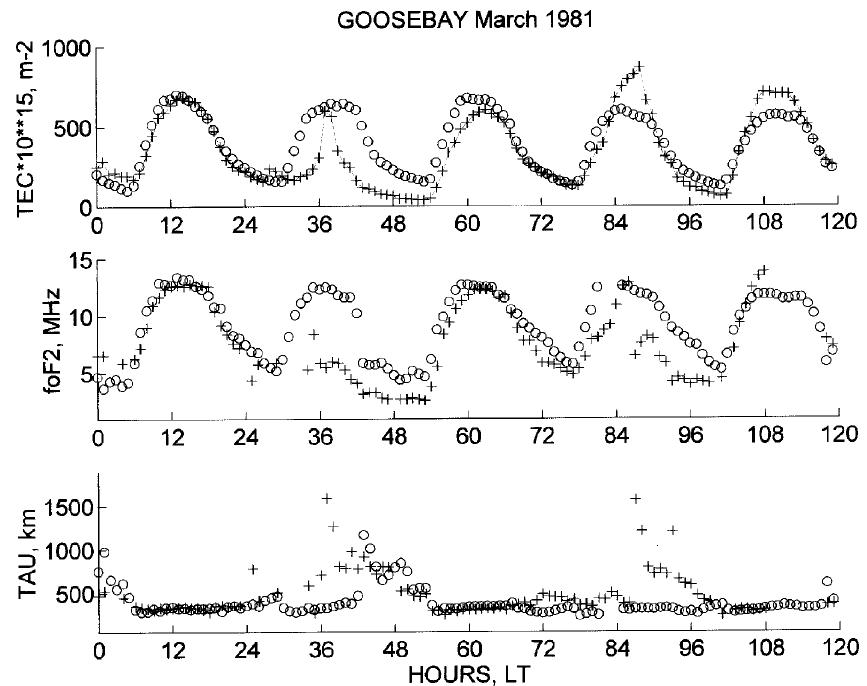
Fig. 1. Variation of total electron con- tent, the F2-layer critical frequency and slab thickness during 5 quiet days (cir- cles) and 5 disturbed days (crosses) of March 1981 at